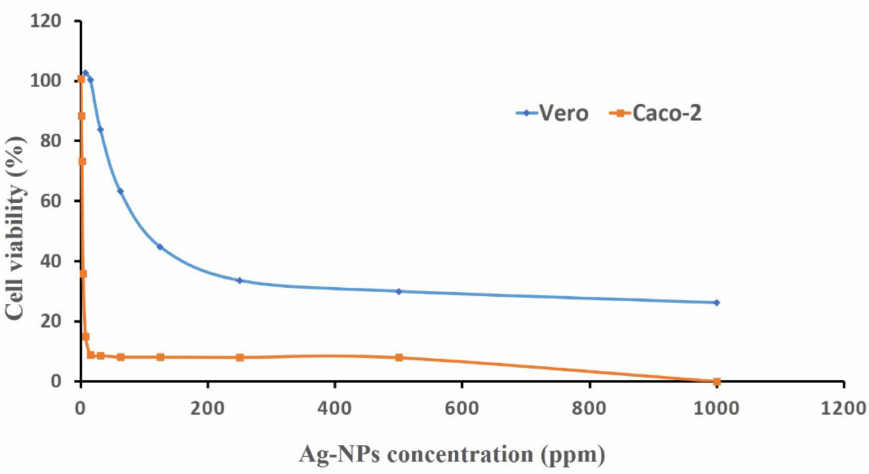
Figure 6. The cytotoxic activity of Ag-NPs derived from Streptomyces laurentii R-1 against Vero and Caco-2 cell